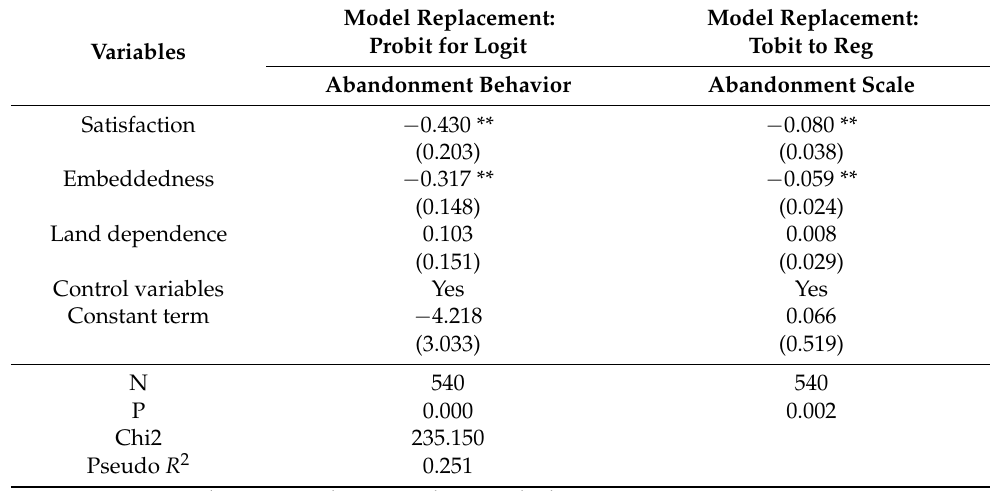
Table 3. Robustness test of the influence of land attachment on land